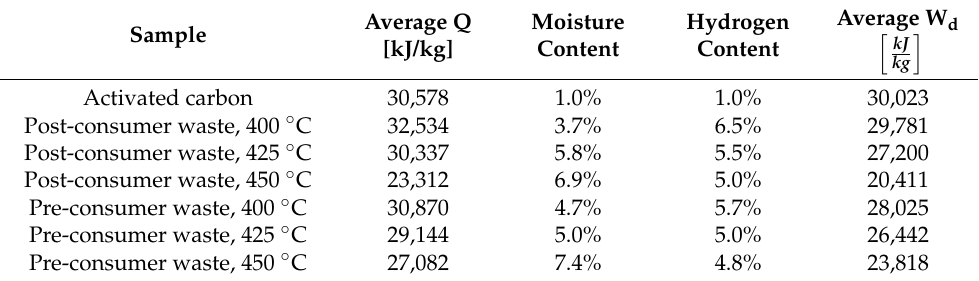
Table 5. Results of analyses of the measured calorific values (Q) and heating values (W d ) for activated carbon and char.